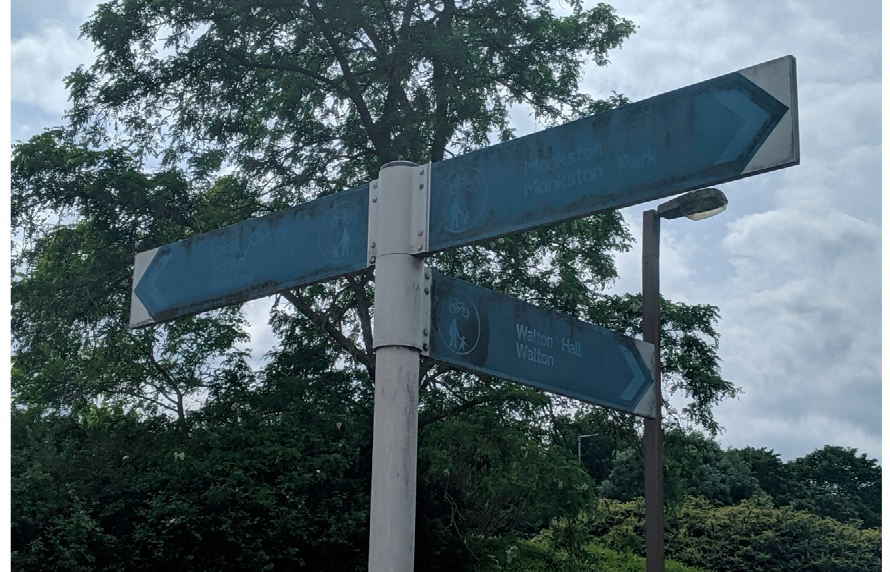
Figure 9. A signpost on a Redway, pointing to three areas: Monkston/Monkston Park, Walton Hall and the Brinklow district/local centre and school. Permission granted by Marston.